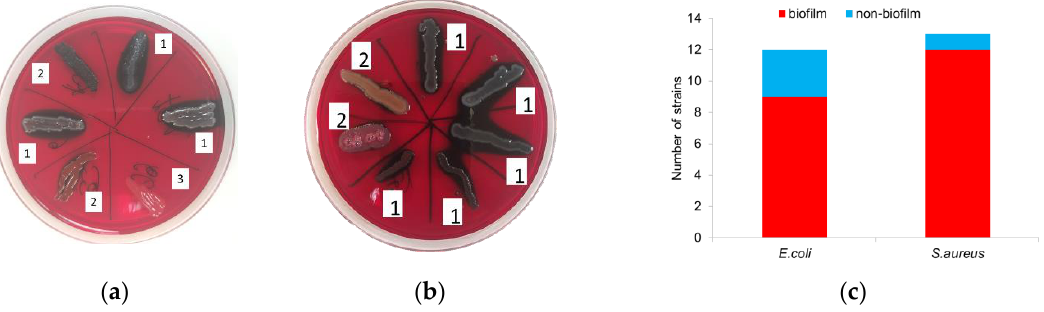
Figure 1. Detection of biofilm-forming uropathogenic strains. Representative images depicting the colonies of E. coli ( a ) and S. aureus ( b ) in the Congo red agar medium (1 – high ability, 2 – medium colonies of E. coli ( a ) and S. aureus ( b ) in the Congo red agar medium (1–high ability, 2–medium ability, 3 – inability to form biofilm) and amount of biofilm-forming strains ( c ). ability, 3–inability to form biofilm) and amount of biofilm-forming strains ( c